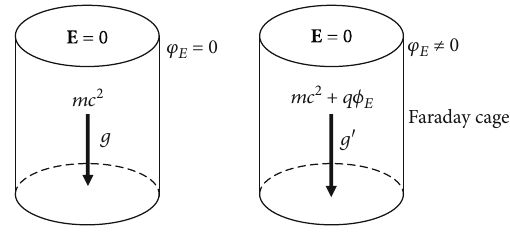
Figure 1: Gravitational